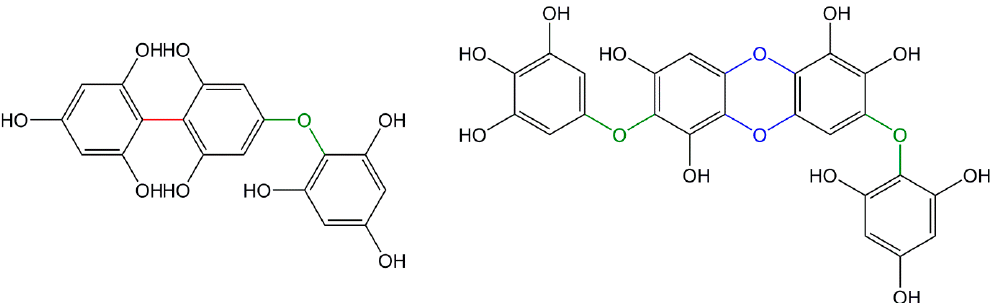
Figure 8. Example of phlorotannins linkages with phenyl bonds (in red), ether bonds (in green) and dibenzo- p -dioxin bond (in blue).